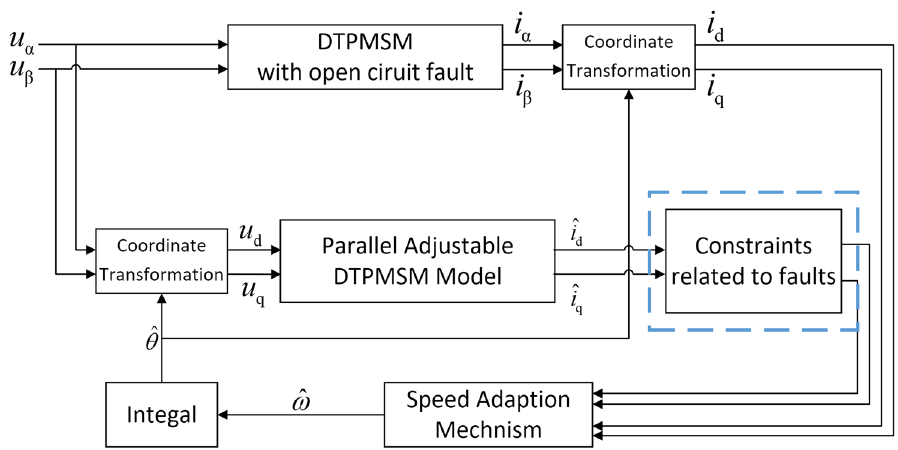
Figure 4. Block diagram of the fault-tolerant control strategy.